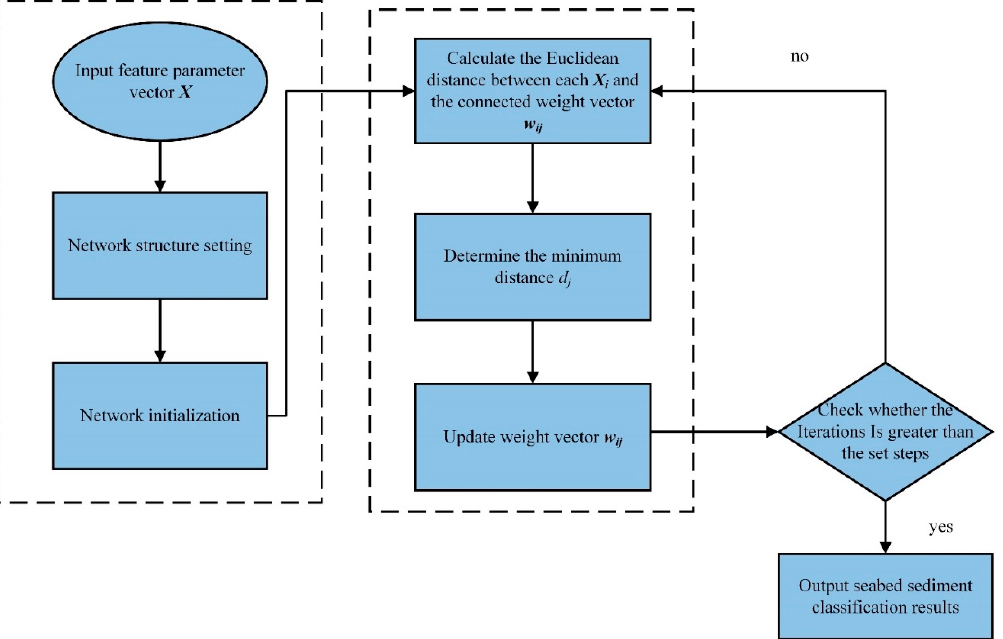
Figure 6. Sketch of the self-organizing map (SOM) network classification.